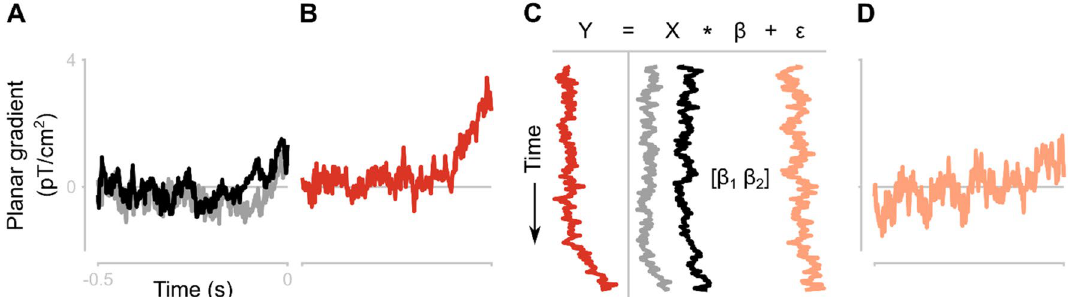
Figure 2. Conceptualization of the linear modelling of planar gradients in the Saccade + stimulus condition as a weighted linear combination of the Saccade-only and Stimulus-only conditions. ( A ) Example planar gradients of one combined planar gradiometer in the Saccade-only (grey) and Stimulus-only (black) conditions. Data are aligned to saccade onset. ( B ) Example planar gradient in the Saccade + stimulus condition. ( C ) Visualization of the general linear model with the planar gradients depicted in A and B. Y = Saccade + stimulus. X = [Saccade- only, Stimulus-only]. ε = residuals. ( D ) Residuals from the general linear model. The residuals represent the surplus of planar gradient in the Saccade + stimulus condition, with respect to the expected planar gradients based on the measurements in the Saccade-only and Stimulus-only